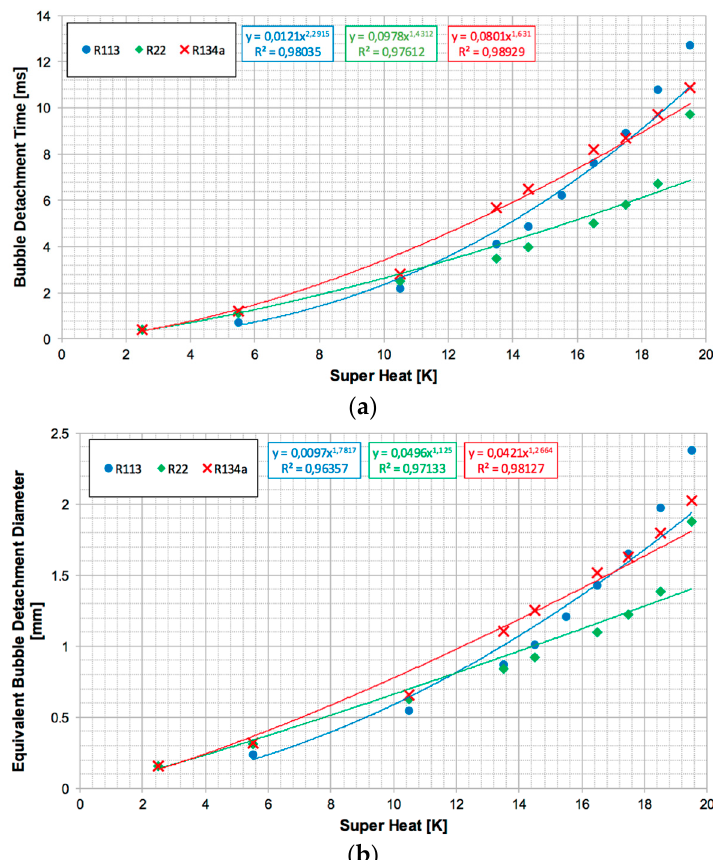
Figure 22. Spatial evolution of generated bubble at the time of detachment for each R134a case of the Series C parametric numerical simulations.